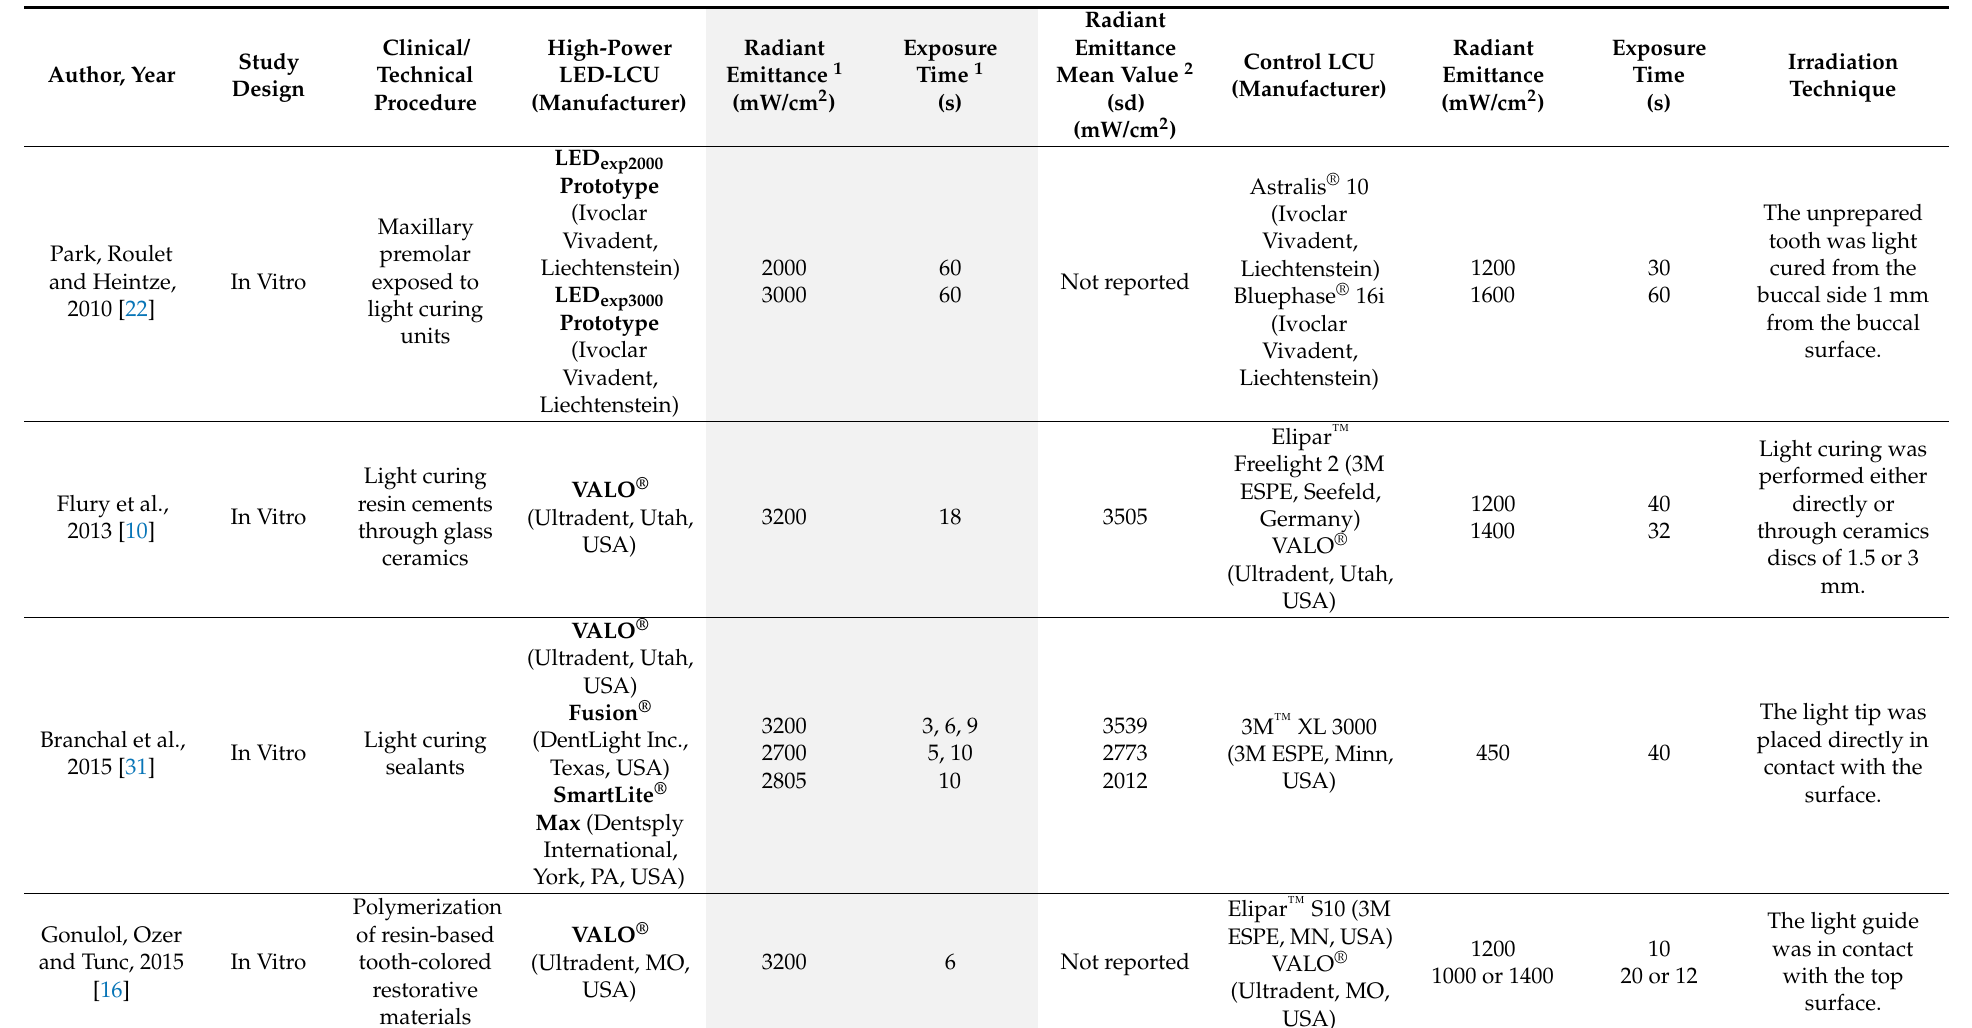
Table 2. Summary of the reviewed